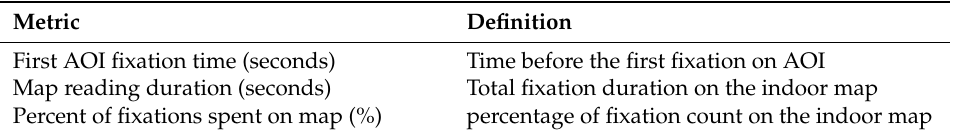
Table 1. Definition of metrics for analysis of map reading.